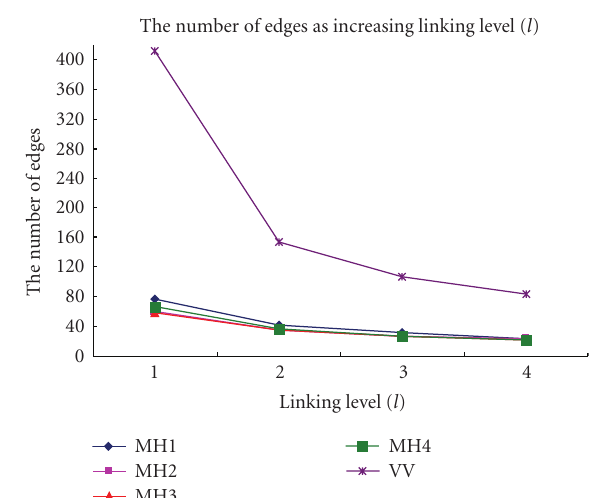
Figure 5: Distribution of the number of edges according to linking level ( l ). ConPath constructed the best sca ff olds at linking level 2 while minimizing edge